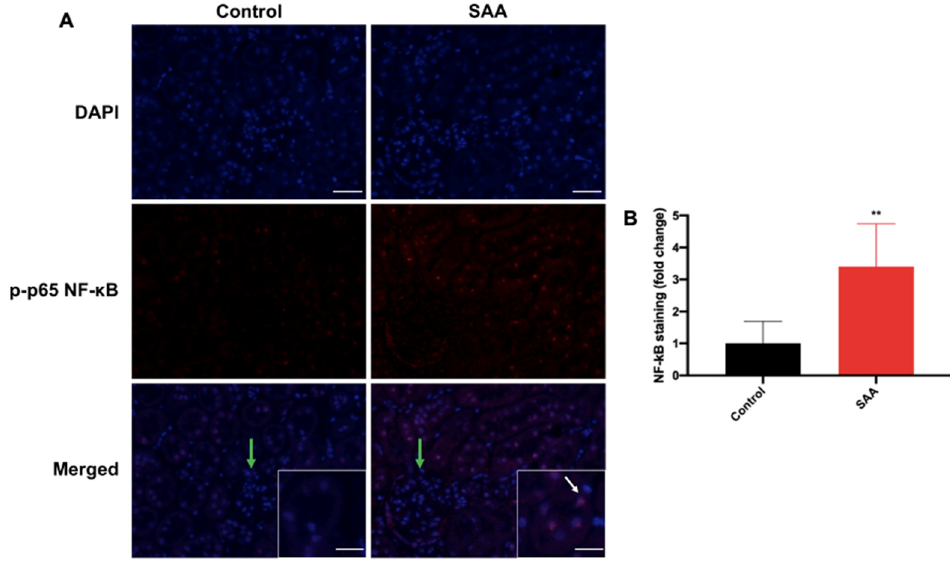
Figure 5. SAA administration stimulates NF-kB p-p65 in the renal cortical tissue. Male ApoE − / − mice were randomly allocated to vehicle control (administered 100 µL PBS every 3 days for 2 weeks) and the SAA group (administered 12 µg SAA protein every 3 days for 2 weeks). Kidney tissue was harvested 4 weeks after cessation of treatment and fixed in situ before embedding and sectioning (5 µm). Renal sections were dewaxed then rehydrated before undergoing heat-induced antigen retrieval. ( A ) NF-kB p-p65 expression was assessed using immunofluorescence microscopy. Slides were visualised at 40× magnification (scale bar = 20 µm); images are representative of at least 4 fields of view for each sample. Nuclei were stained with DAPI (blue) and NF-kB p-p65 with an appropriate Opal fluorophore (red). White arrows show NF-kB+ staining localised to renal epithelial cells and not in the glomerular endothelium (glomeruli indicated by green arrow). Insets show higher magnification (scale bar = 10 µm) images of renal tubular epithelial cells with NF-kB p-p65+ staining largely colocalised to nuclei with some residual cytoplasmic staining. Representative images show cortical fields from n = 5 (control), n = 6 (SAA). ( B ) Immunostaining was quantified using a mean staining intensity for each field of view and averaged for each sample. Data shown as relative mean ± SD. ** Different to the control group; p < 0.001.